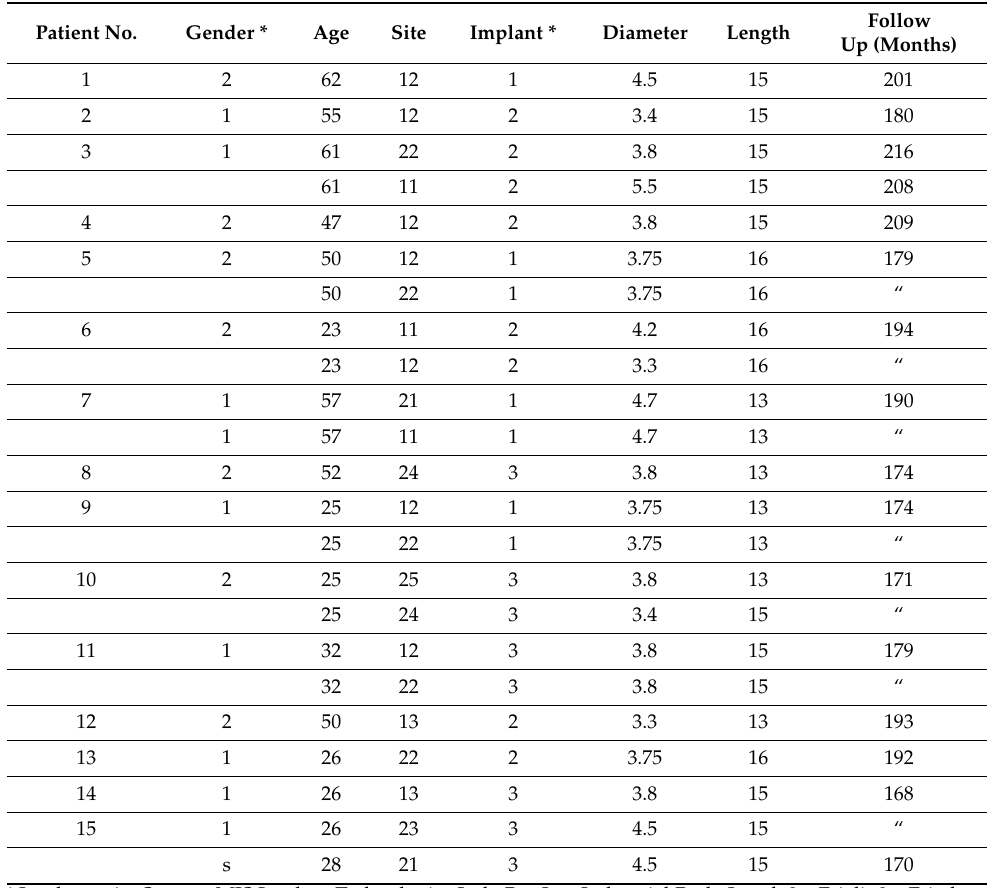
Table 1. Summary of basic demographic, site of implantation, implant type, diameter and length, and follow-up